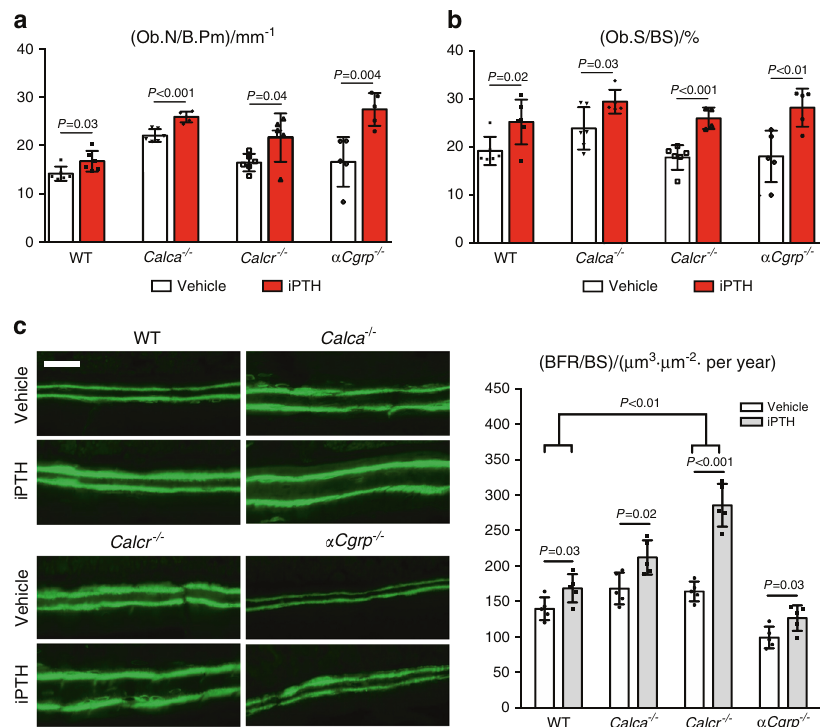
Fig. 3 Enhanced anabolic response of osteoblasts to iPTH in mice lacking Calca and Calcr . a , b Quanti fi cation of the number of osteoblasts per bone perimeter (Ob.N/B.Pm) and osteoblast surface per bone surface (Ob.S/BS) in trabecular bone of spine sections from the indicated groups following 4 weeks of treatment with iPTH (100 μ g·kg − 1 ) or vehicle. n = 5 – 6 mice per group (one-way ANOVA followed by Tukey ’ s post hoc test). c Representative fl uorescence images of double calcein labeling in trabecular bone of spine sections (scale bar = 25 μ m) and quanti fi cation of the bone formation rate per bone surface (BFR/BS). n = 5 mice per group. Comparisons between vehicle- and iPTH-treated mice of each genotype were performed with unpaired Student ’ s t test. Comparisons between the relative alterations in each group